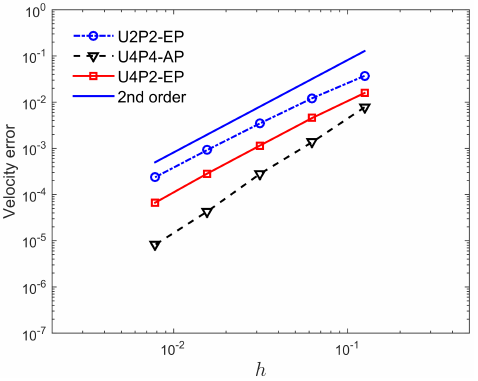
Figure 4. Computation errors ( L ∞ norm) of x -velocity error in the Burggraf flow problem.